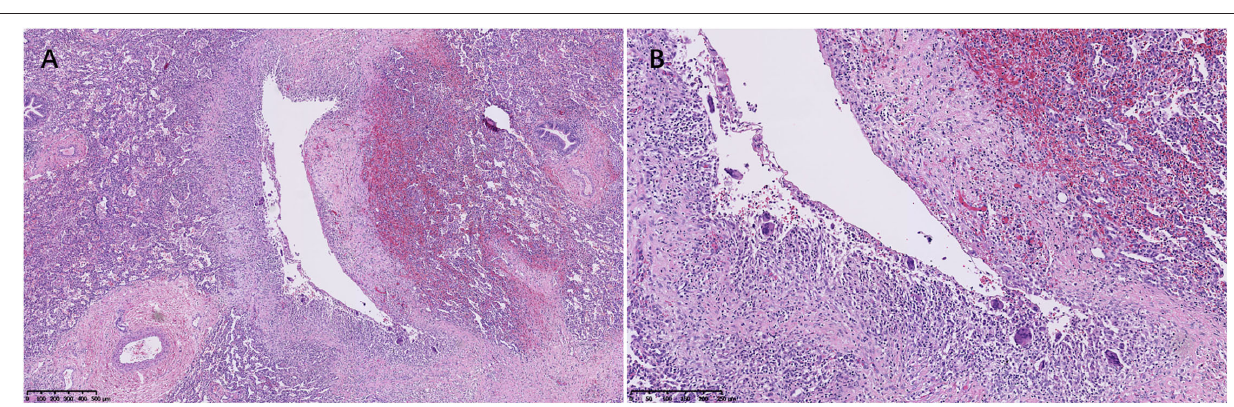
Frontiers in Pediatrics |